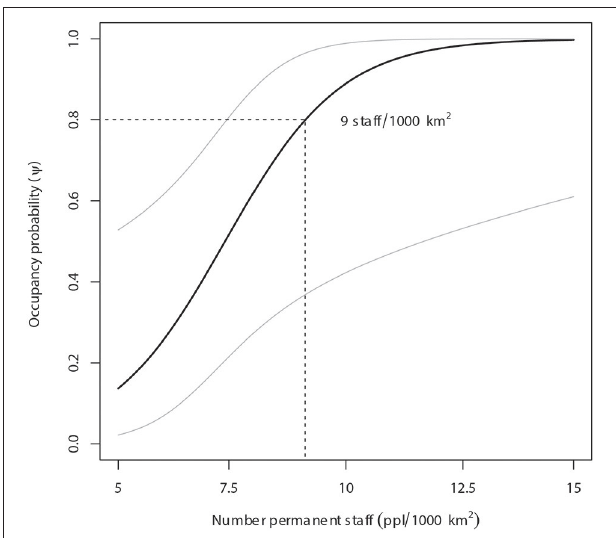
FIGURE 4 | Lion occupancy estimates in WAP (with 95% Prediction Intervals) given variation in mean monthly dry season (March to May) precipitation (mm). Our model predicts that areas with a minimum lion occupancy probability of 80% receive at least 43 mm of monthly precipitation in the dry season.